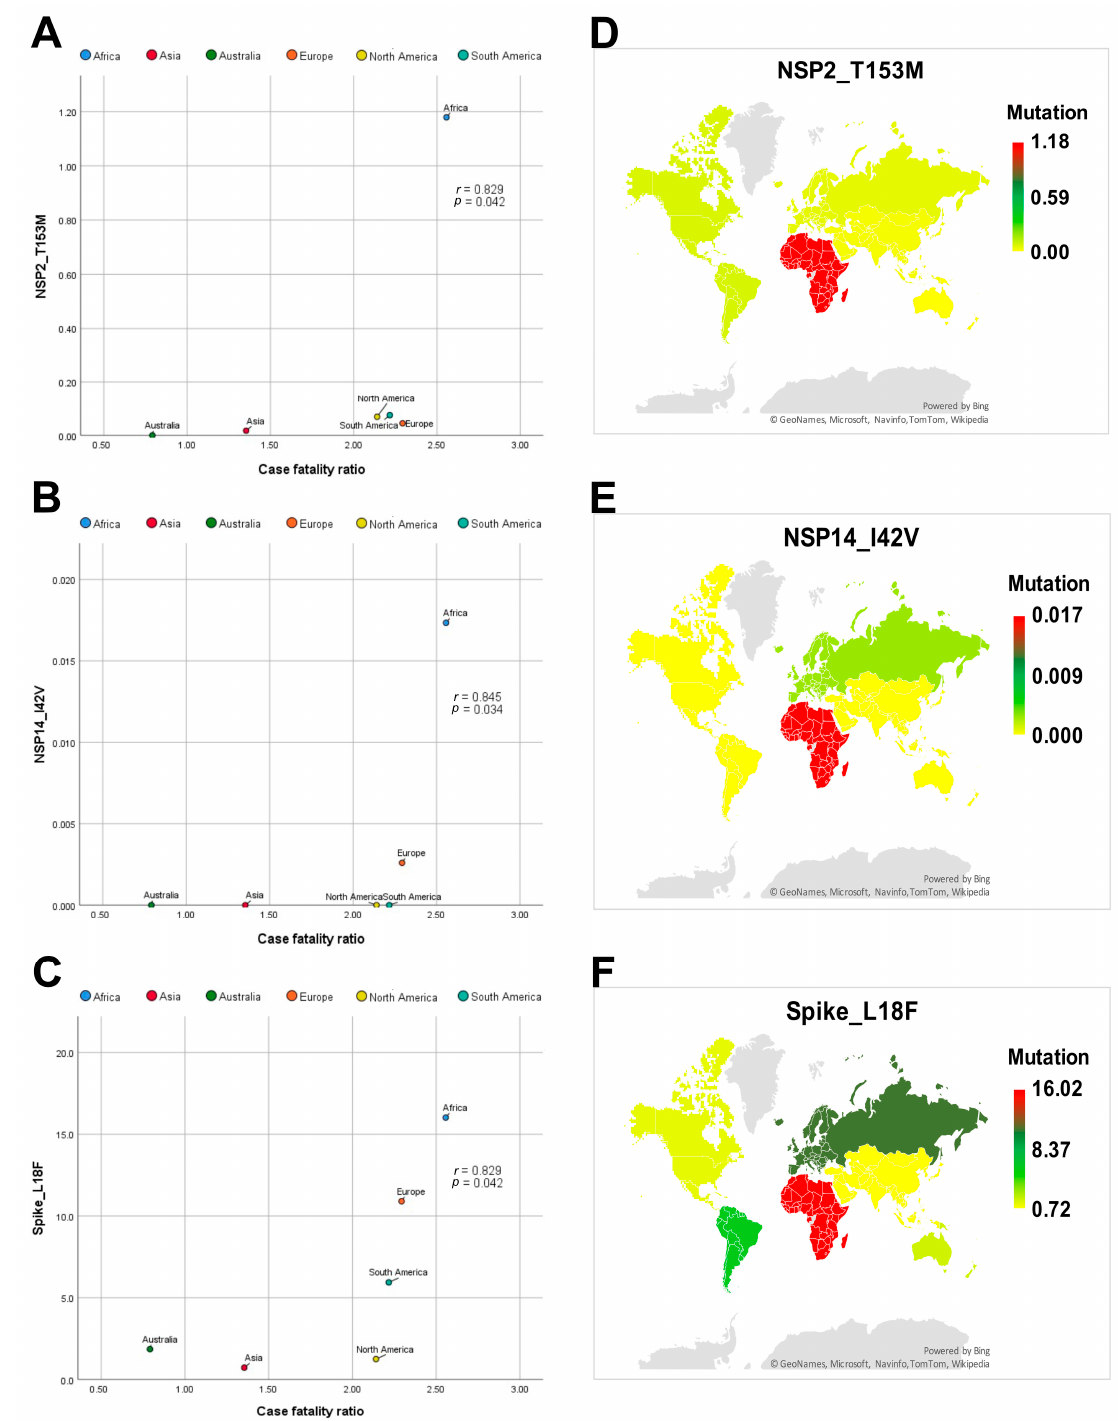
Figure 2. Correlation analysis and global mapping of mutations having a positive correlation with CFR among different world continents. ( A ) Spearman’s correlation between NSP2_T153M mutation and CFR among different world continents, ( B ) Spearman’s correlation between NSP14_I42V mutation and CFR among different world continents, ( C ) Spearman’s correlation between Spike_L18F mutation and CFR among different world continents, ( D ) Global mapping of NSP2_T153M mutation having a positive correlation with CFR among different world continents. ( E ) Global mapping of NSP14_I42V mutation having a positive correlation with CFR among different world continents. ( F ) Global mapping of Spike_L18F mutation having a positive correlation with CFR among different world continents r: Spearman’s correlation coefficient. p : p